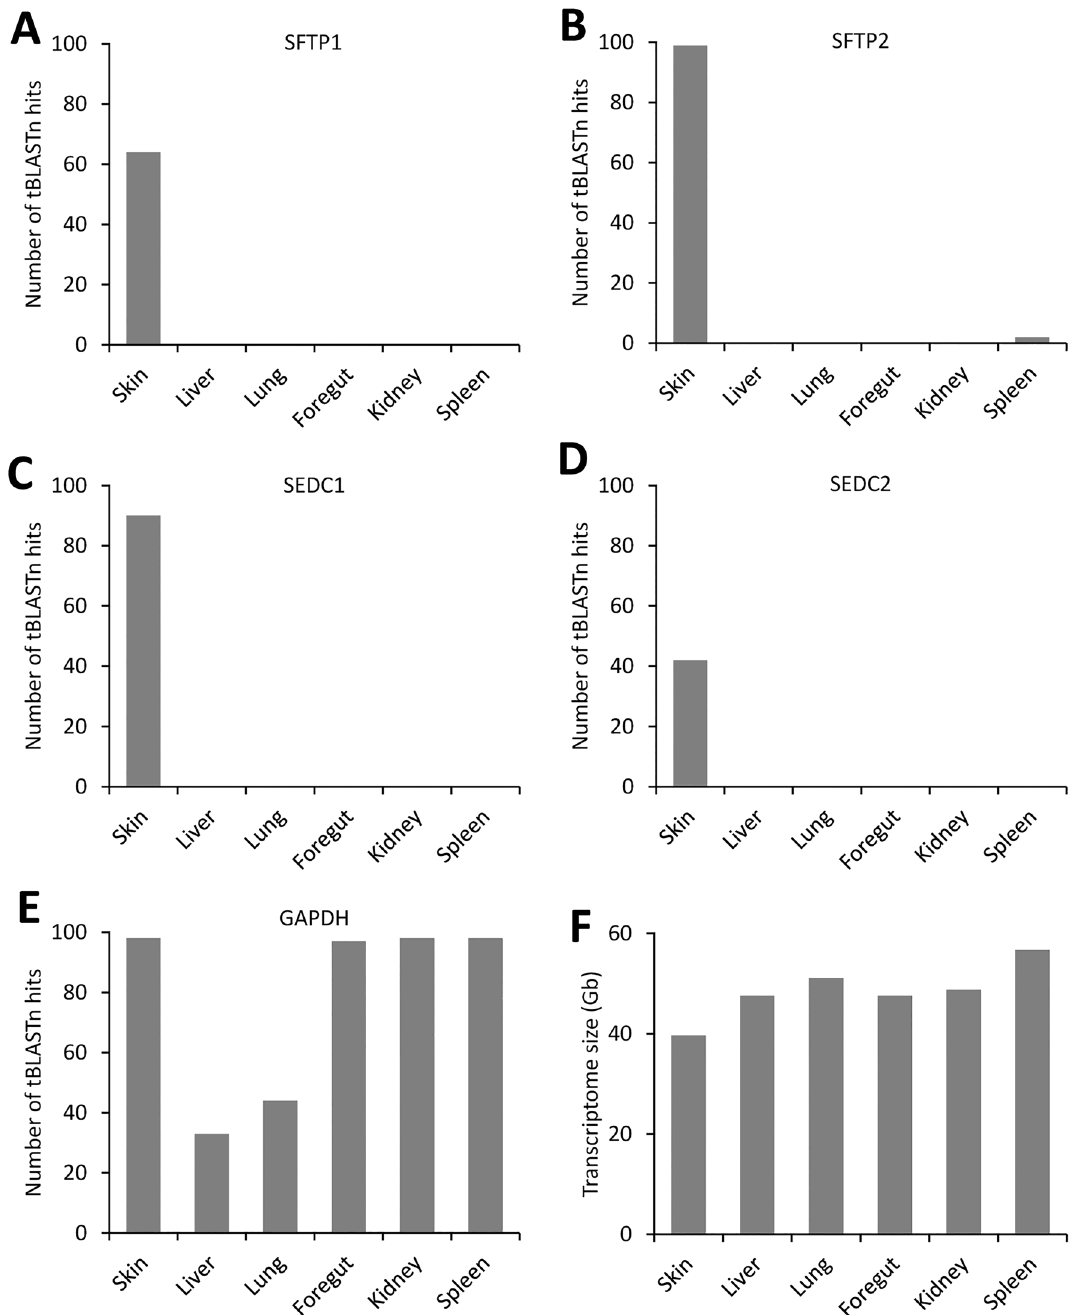
Figure 2. Semiquantitative analysis of EDC gene expression in tissue transcriptomes of Rhinatrema bivittatum . ( A – E ) Sequence fragments of the predicted proteins as described in the “Methods” section were used as queries for tBLASTn analysis. The accession numbers for the transcriptomes were as follows: skin (SRX2848310), liver (SRX2848294), lung (SRX2848293), foregut (SRX2848291), kidney (SRX2848286), spleen (SRX2848287). Default settings of tBLASTn were used except for deactivation of the filter for low complexity regions. tBLASTn hits with 100% sequence identity to the query were counted. GAPDH was investigated as a house-keeping gene ( E ). Note that this analysis allows comparison of expression levels of a particular gene in different organs, but not comparison between expression levels of different genes. ( F ) Size of tissue transcriptomes. Gb